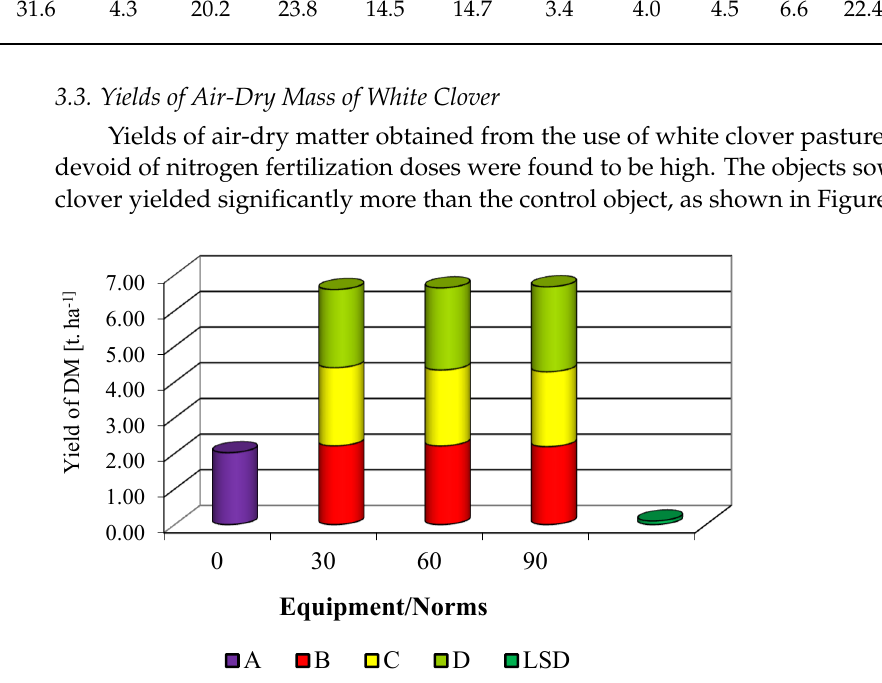
Figure 4. The influence of tillage equipment’s, reseeding norms and years of T. repens on the yield of ADM (Mean of pasture rotations). Tillage treatments: A—control object (without overseeding), B—underseeding after heavy tine harrow, C—underseeding after disc harrow, D—underseeding after the rotary tiller. A clear and significant difference in ADM annual yields was observed between the different years of the study. The highest yields of ADM were obtained during the first three years after sowing (as shown in Figure 4). However, over time, the yields decreased